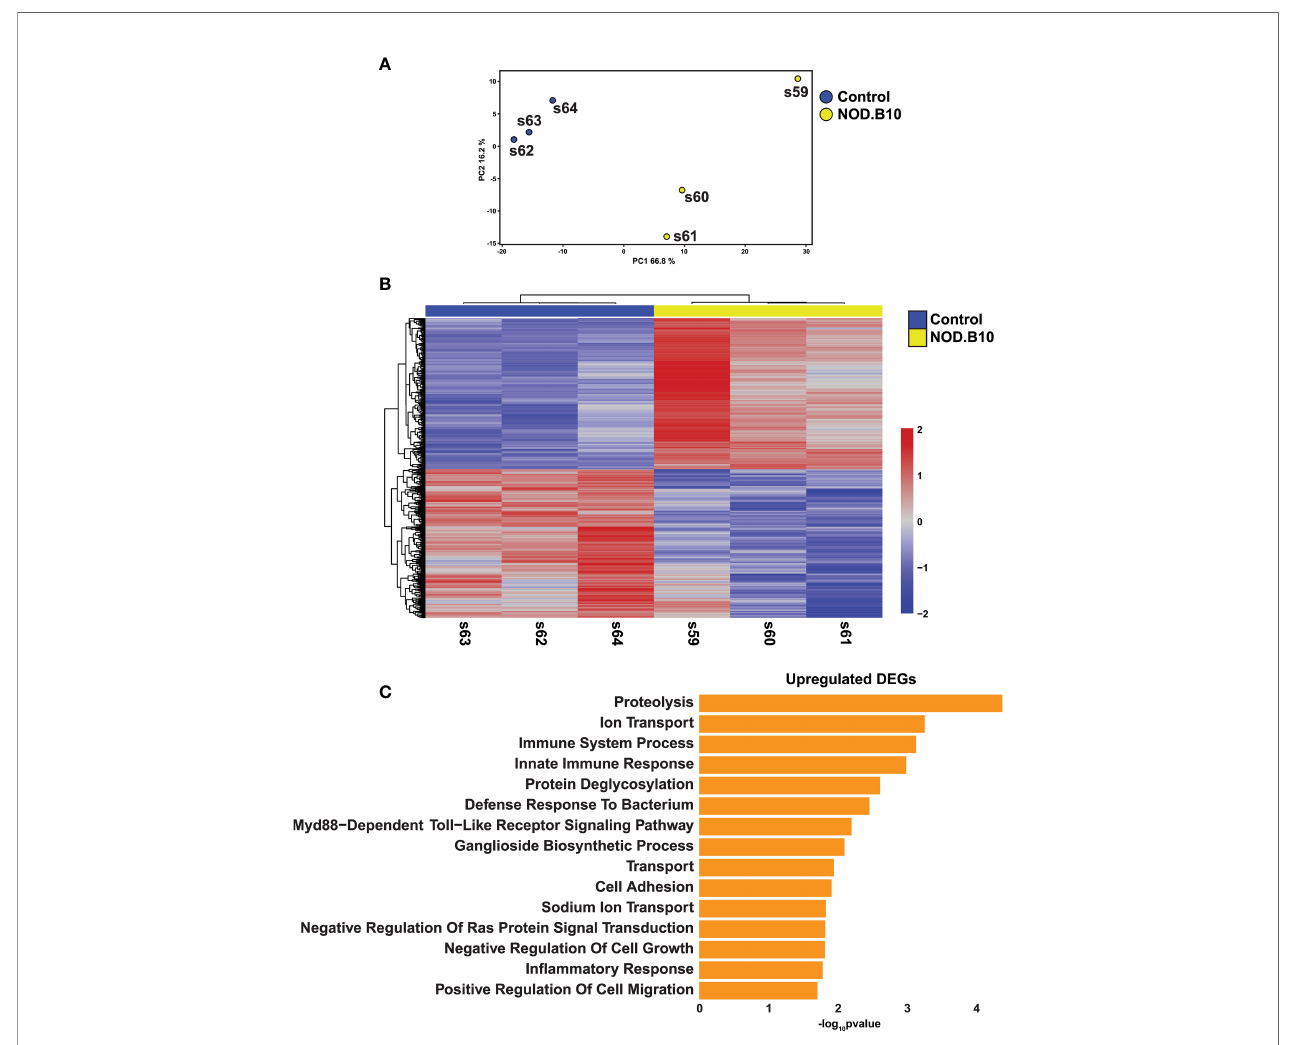
FIGURE 1 | Comprehensive Transcriptomic Analysis of Submandibular Salivary Glands of NOD.B10 pSS Mice. (A) Plot shows Principal Component Analysis (PCA) coordinates for three control and three NOD.B10 mouse salivary glands. Blue and yellow circles represent control and NOD.B10 mice, respectively. (B) Heatmap visualization of differentially expressed genes (DEGs) in submandibular salivary glands of the control and NOD.B10 mice. (C) Bar plot highlighting enriched biological processes in the top 200 upregulated DEGs identi fi ed in panel (B)